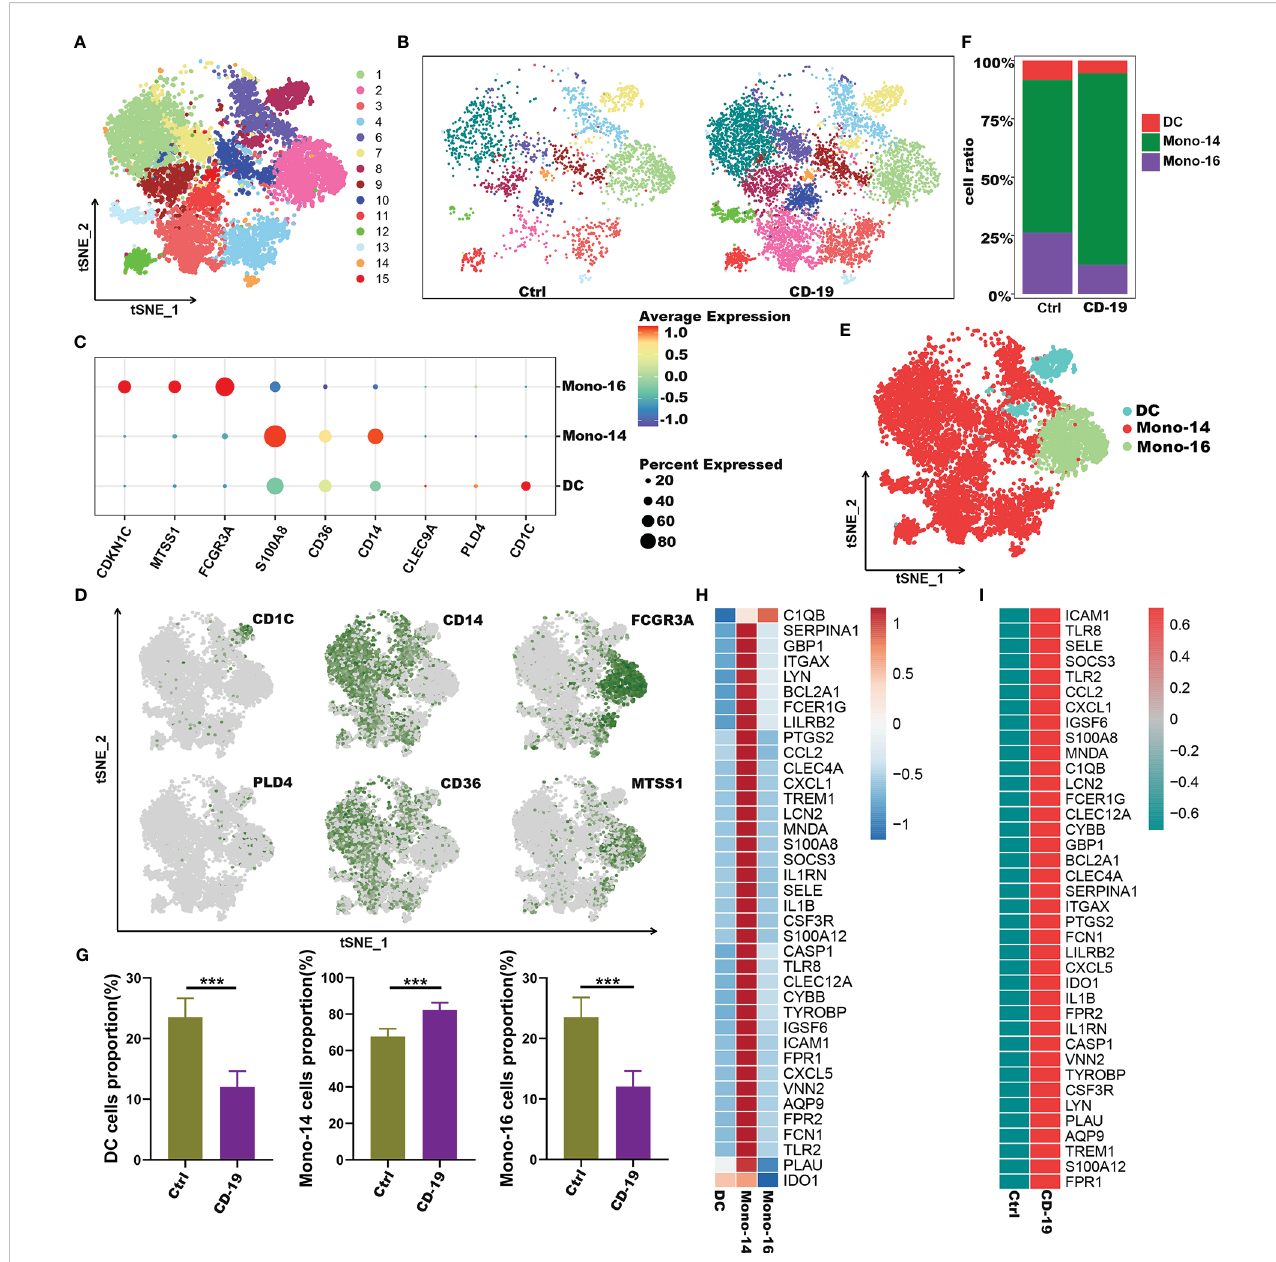
FIGURE 6 Immune characteristics of the hub genes at the single-cell atlas in myeloid cell metaclusters with COVID-19. (A) t-SNE plot visualizing the clusters of myeloid cells. (B) t-SNE plot visualization of the clusters between COVID-19 and healthy controls. (C) Dot plot depicting the expression level of signi fi cant marker genes. (D) t-SNE plot of marker genes enriched in subpopulations of myeloid cells. (E) t-SNE plot of subgroups of myeloid cells in COVID-19. (F) Proportion of subgroups of myeloid cells in COVID-19 and healthy controls. (G) Bar plots showing the relative frequencies of different myeloid cells subgroups in COVID-19 and healthy controls. (H) Heatmap showing gene expression patterns of hub genes in subpopulations of myeloid cells. (I) Heatmap showing expression patterns of hub genes in CD14 + monocyte cells between COVID-19 and healthy controls. *** p < 0.001; ns, not signi fi